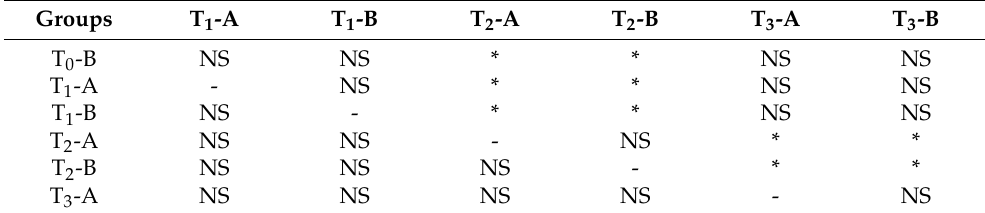
Table 9. Statistical analysis using t-test applied to the mean histamine concentration detected in the various group of samples stored in different environmental